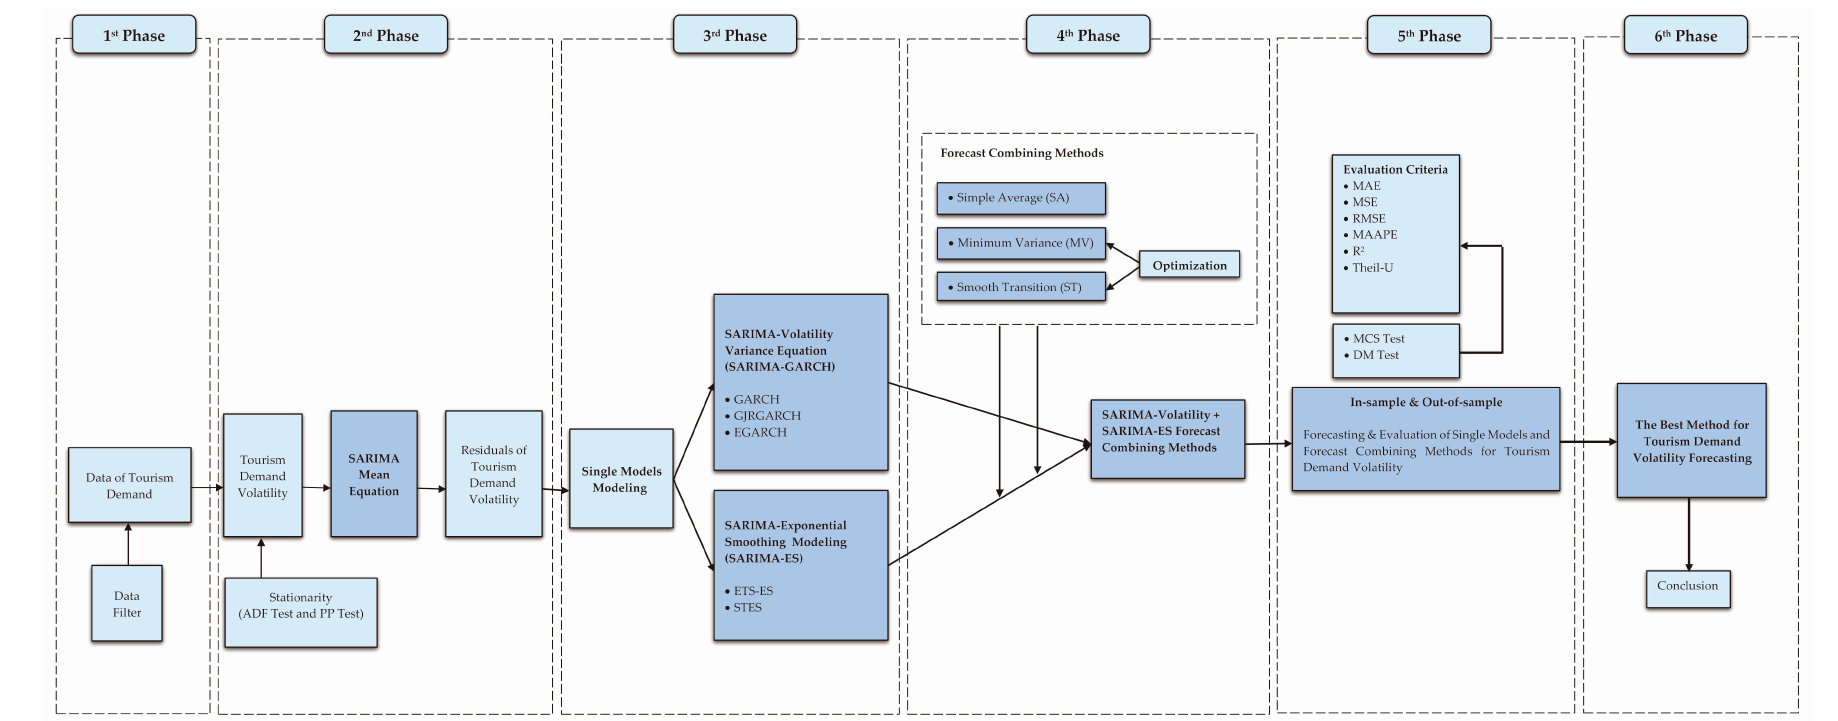
Figure 3. Research derivation for tourism demand volatility